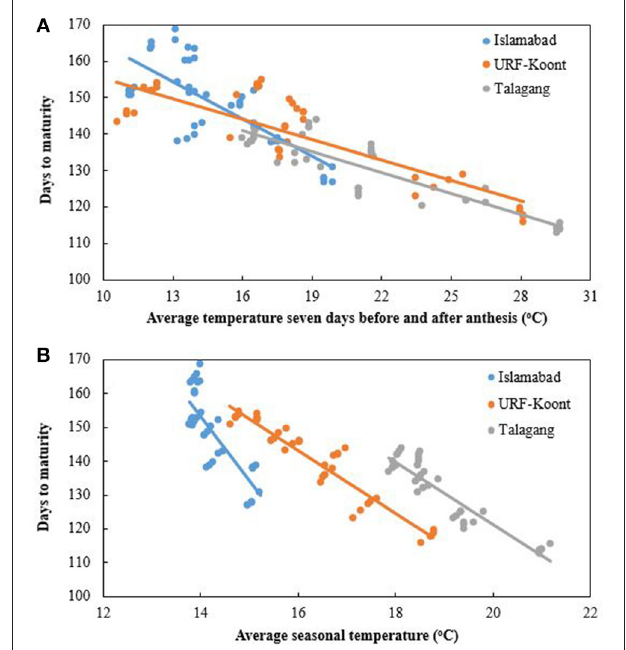
FIGURE 2 | Trend line for number of days to maturity at Islamabad, URF Koont and Talagang including four sowing dates and 2 years as a function of (A) average temperature 7 days before and after anthesis, and (B) average seasonal temperature.